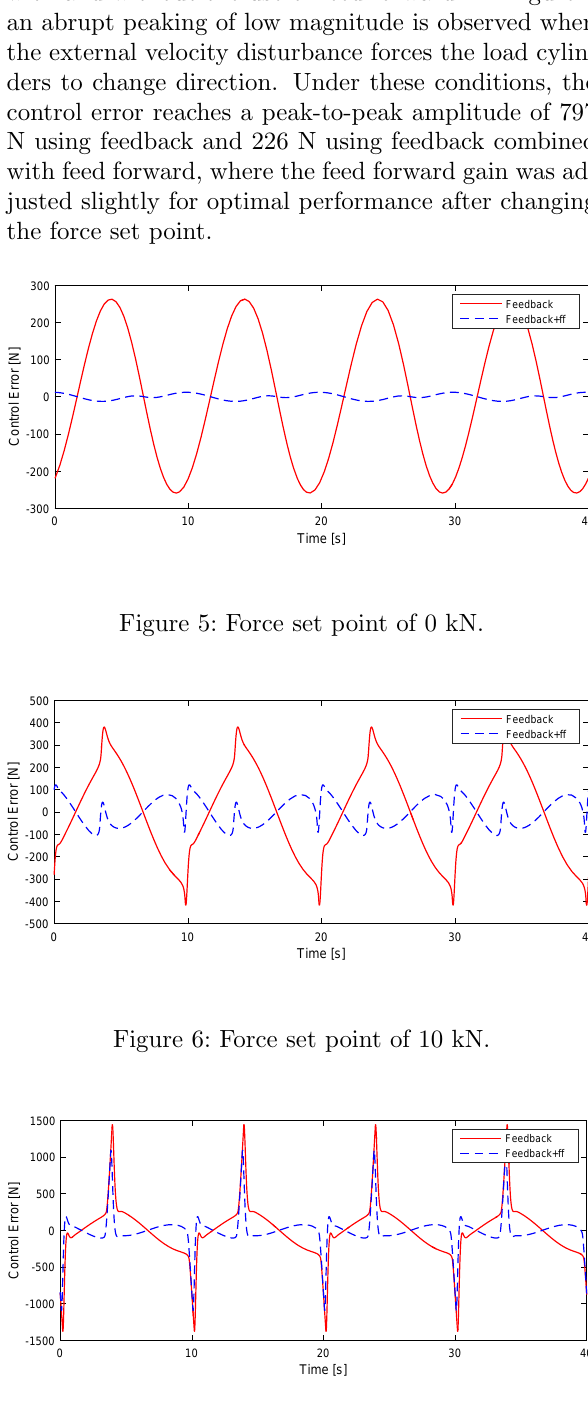
Figure 7: Force set point of 10 kN and a valve dead- band of